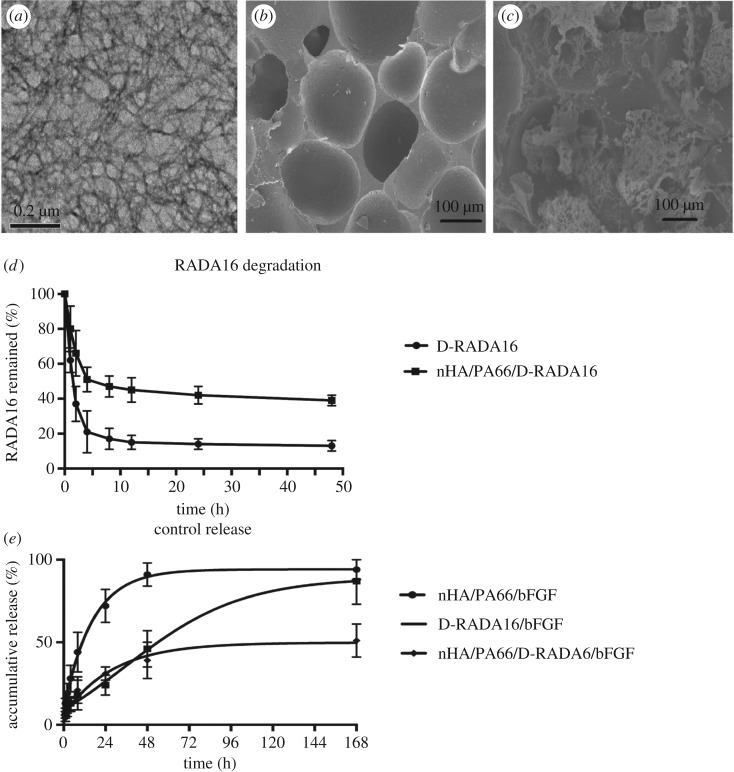
The results of material characterization, D-RADA16 degradation and bFGF sustained release. (a–c) Materials characterization and (d) degradation, (e) bFGF sustained release. (a) TEM image showing the microstructure of a D-RADA16 hydrogel. (b,c) SEM images showing the microstructures of (b) nHA/PA66 and (c) nHA/PA66/D-RADA16/bFGF composites. (d) Degradation of D-RADA16 using proteinase K test (n = 3). (e) bFGF release with proteinase K test (n = 3).